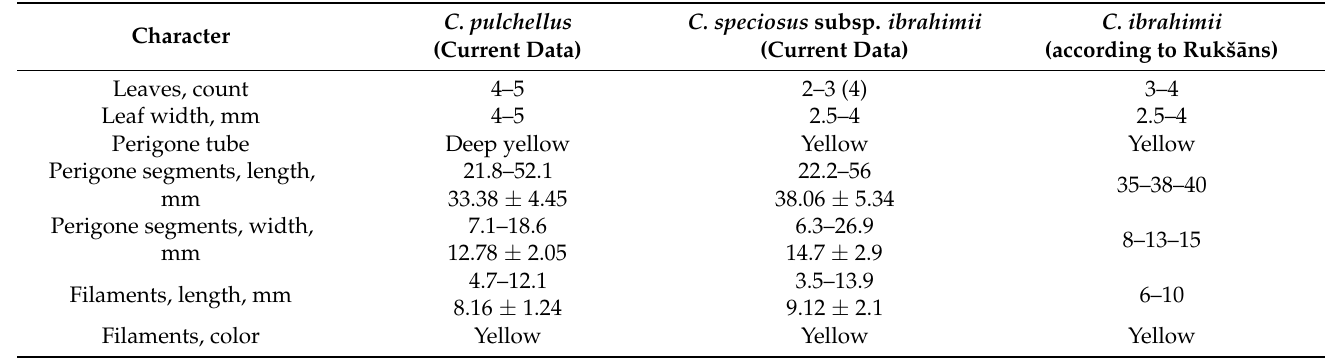
Table 1. A comparison of the morphological features of Crocus pulchellus and C. speciosus subsp. Ibrahimiii *